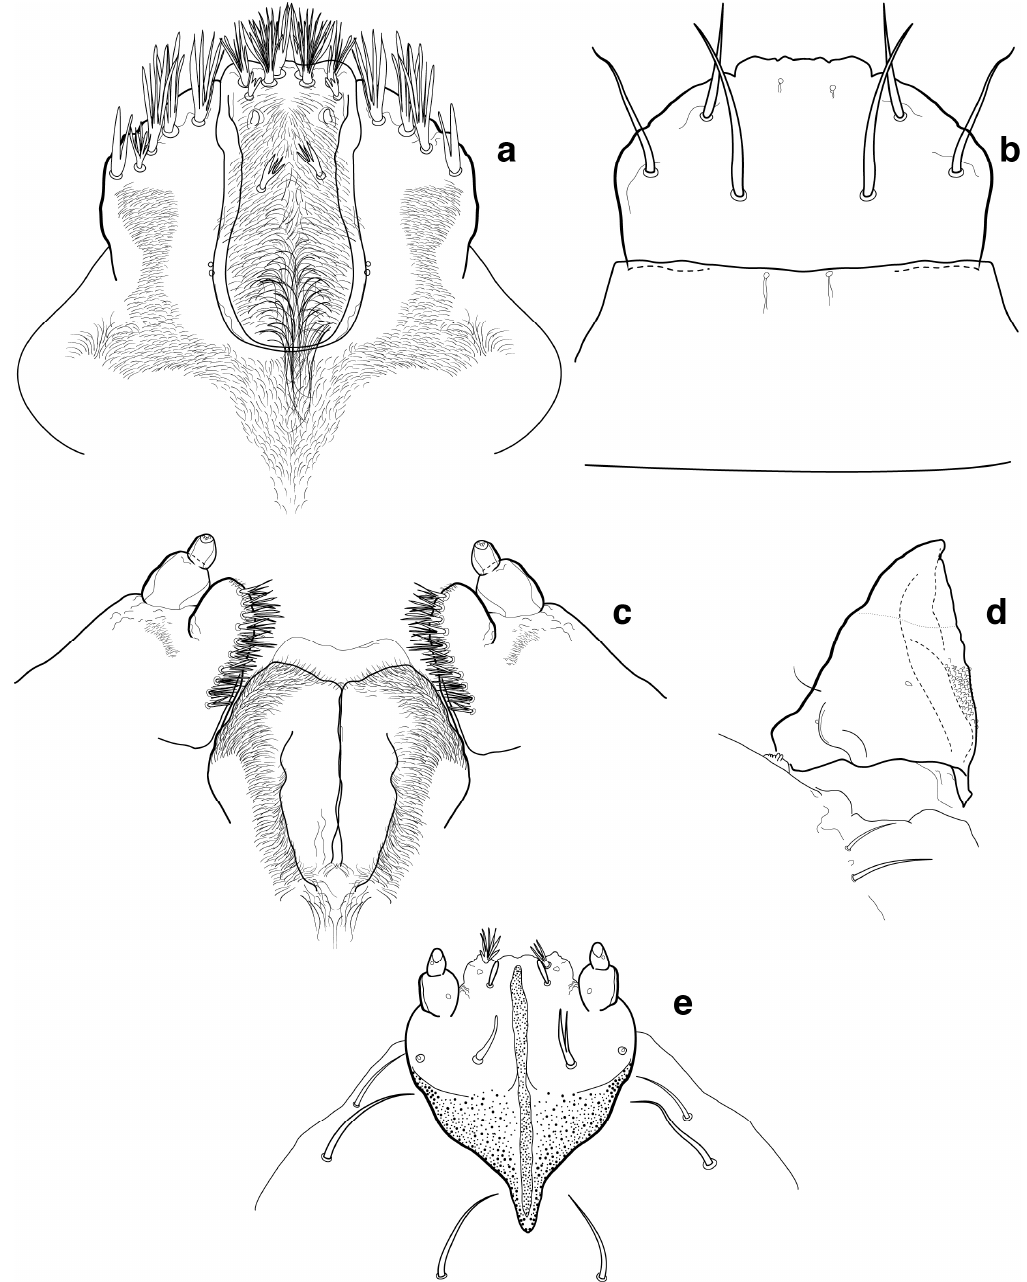
Figure 92. Yuccaborus lentiginosus mouthparts: ( a ) epipharynx; ( b ) clypeus (incomplete) and labrum; ( c ) detail of hypopharynx and maxillae, dorsal view; ( d ) mandible and antenna; and ( e ) labium, ventral view.